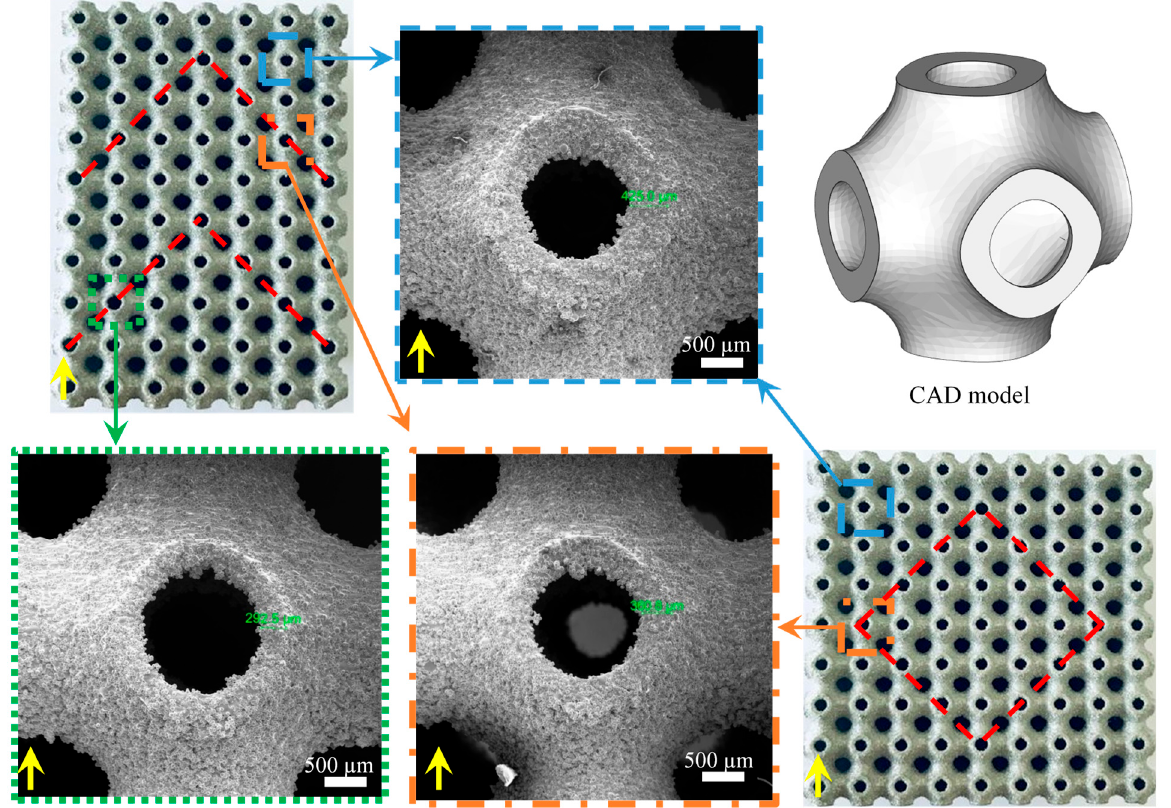
Figure 5. Additively manufactured samples with graded structure and SEM images of selected cells. Inset arrows at the bottom left of each subfigure indicate the printing direction.